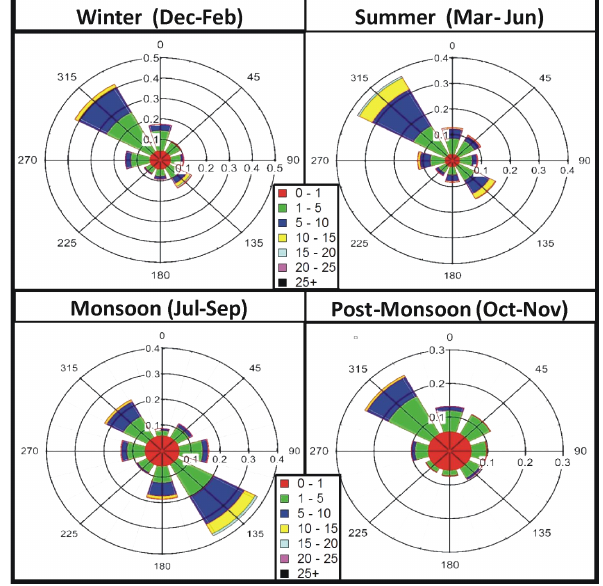
Figure 2. Wind rose plot for the measurement site for the win- ter (December–February), summer (March–June), monsoon (July– September) and post-monsoon (October and November) seasons. Wind speed and wind direction were measured at a height of